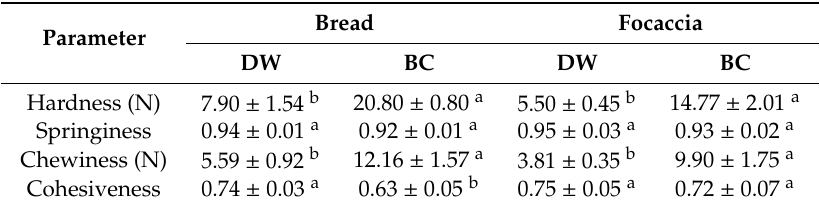
Table 9. Textural parameters of conventional durum wheat bread and focaccia and of their black, chickpea-enriched versions. DW = product prepared by using durum wheat re-milled semolina; BC = product prepared by using a composite meal containing 60 / 100 g of durum wheat re-milled semolina and 40 / 100 g of Apulian black chickpea wholemeal flour.